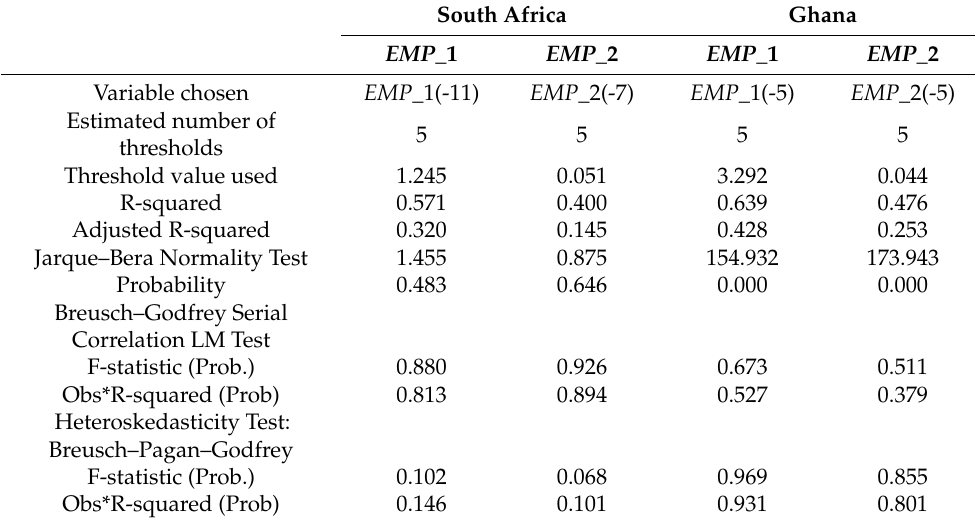
Table A4. Threshold regression results for South Africa and